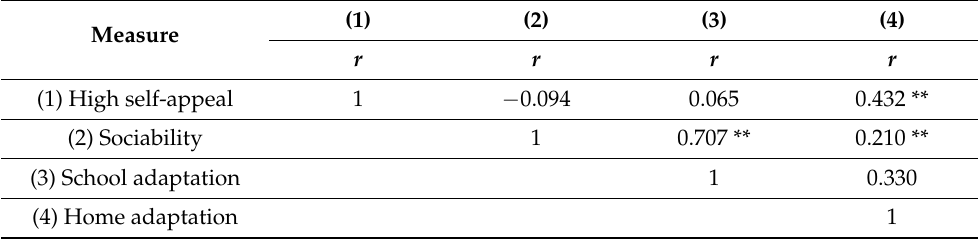
Table 2. Bivariate correlation matrix: Pearson (N = 467).